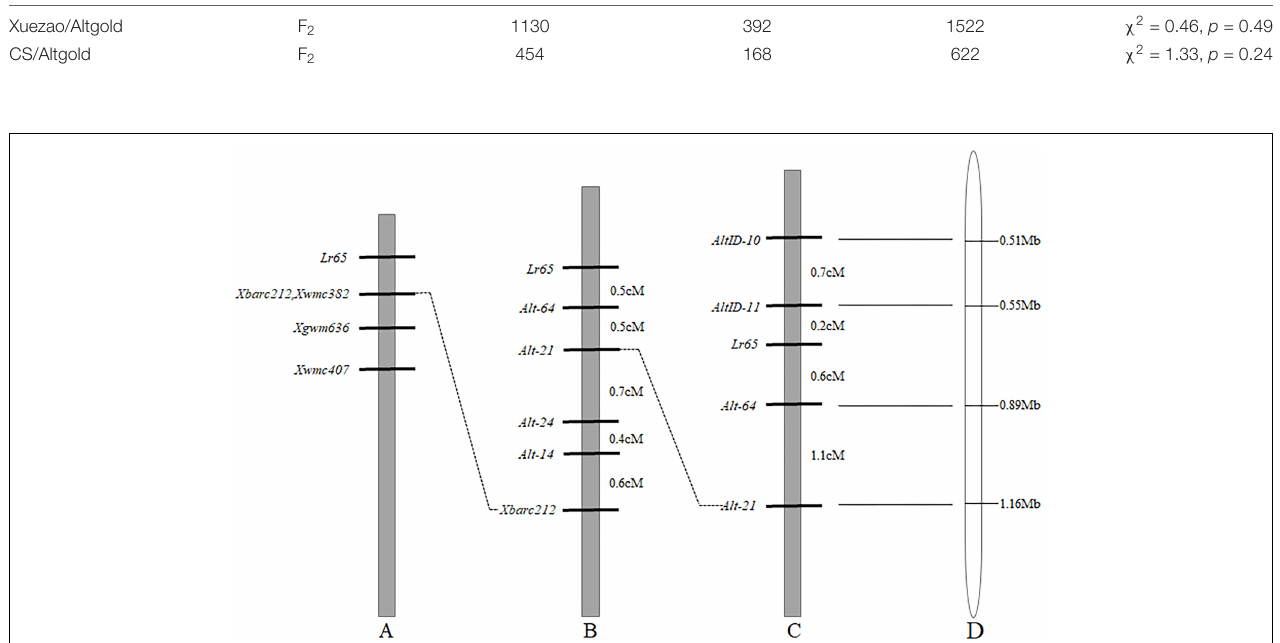
FIGURE 2 | Comparison of genetic linkage maps of Lr65 on chromosome 2AS and the corresponding physical location on Chinese Spring RefSeq v1.0. (A) Previous map of Wang et al. (2010). (B) The map of Lr65 in current study based on Xuezao/Altgold F 2 population, genetic distances were indicated in cM on the right-hand side. (C) The map of Lr65 in current study based on CS/Altgold F 2 population, genetic distances are indicated in cM on the right-hand side. (D) The physical location of markers of Lr65 on the chromosome 2AS of Chinese Spring RefSeq v1.0. The physical distances were shown on the right in Mb.